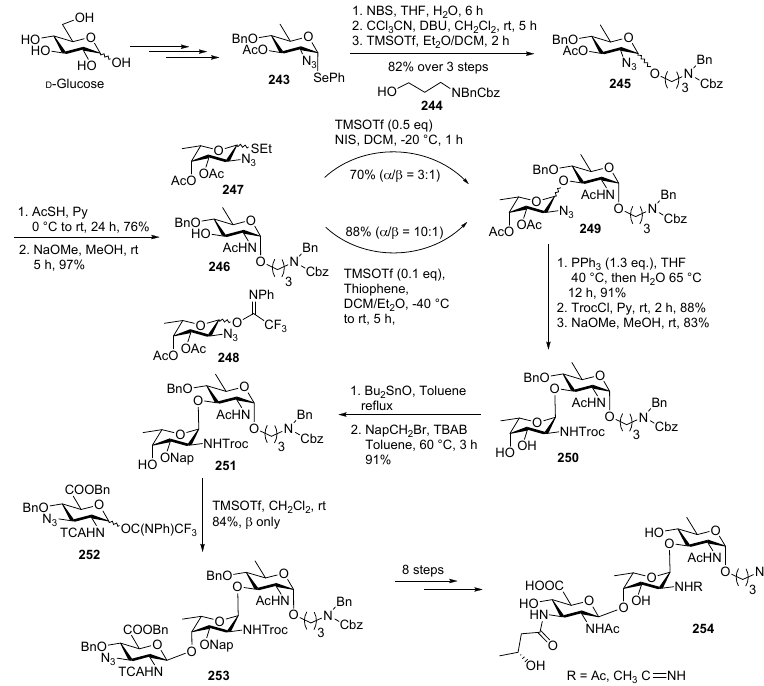
Scheme 28. Synthesis of P. shigelloides serotype 51 aminoglycoside trisaccharide antigen.